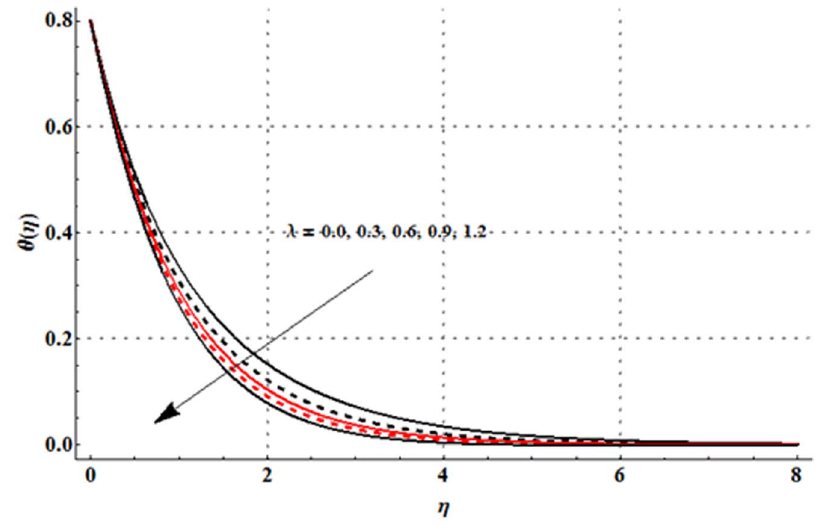
Figure 11. Influence of l 1 on the temperature profile h ( g ) when M ~ 0 : 6, b ~ 0 : 4 ~ Rd , l ~ 0 : 3 ~ N , Pr ~ 1 : 2, S ~ 0 : 2 ~ S (cid:2) and Sc ~ 1 : 0 :